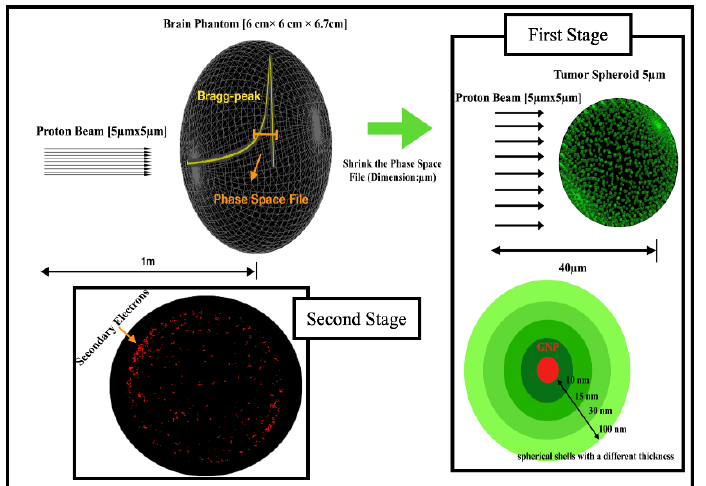
Figure 1. Schematic diagram of geometry used in this study. First stage: recorded phase-space files (PSFs) were rescaled to GNP size to expose them and considered as new sources to investigate dose deposition around GNPs in spherical shells with a thickness of 100 nm, in addition to counting secondary electrons recorded in spherical shells. Second stage: studying the spectrum of electrons in water.